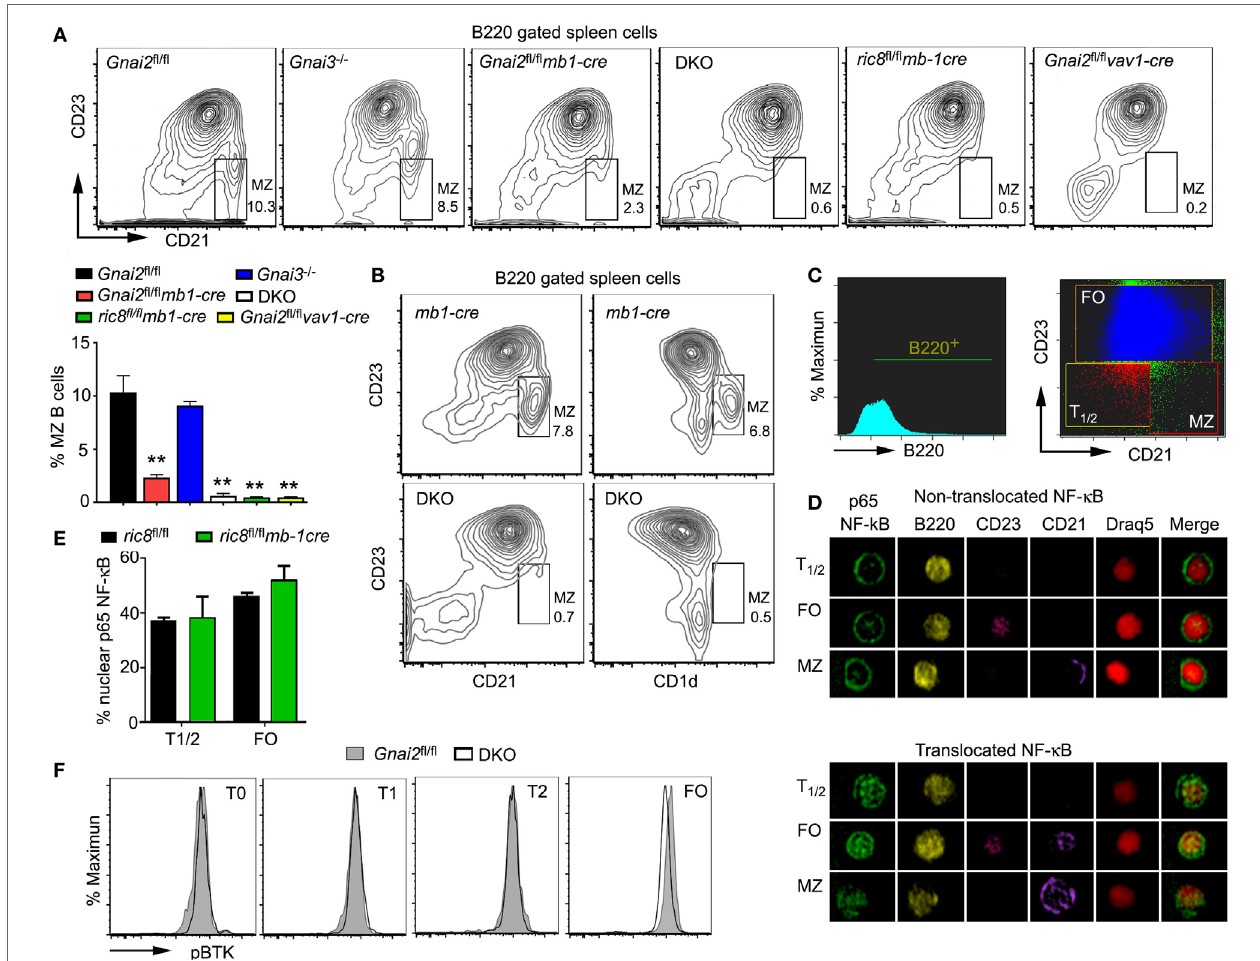
FigUre 1 | Despite the reduction in splenic marginal zone (MZ) B cells in G α i -deficient mice, their transitional B cells do not exhibit evidence of reduced BCR signaling. (a) Lack of MZ B cells in various models of G α i deficiency. Flow cytometry patterns using splenic B cells from G α i -deficient mice. CD23 versus CD21 on WT (Gnai2 fl/fl ), Gnai3 − / − , Gnai2 fl/fl mb1-cre , double knockout (DKO), ric8 fl/fl mb1-cre , and Gnai2 fl/fl vav1-cre B220 + splenocytes. The normal location of MZ B cell is boxed and % of cells indicated. The chart shows percentage of MZ B cells from the B220 + cell gate. Results are from nine WT, five Gnai3 − / − , five r ic8 fl/fl mb1-cre , eight Gnai2 fl/fl mb1-cre , four Gnai2 fl/fl vav1-cre , and four DKO mice. Data shown as mean ± SEM (** p < 0.005). (B) Spleens from G α i -deficient mice also lack CD1d-positive cells. Flow cytometry patterns using splenic B cells from WT and DKO mice. CD23 versus CD21 and CD23 versus CD1d on B220 + splenocytes from mb1-cre and DKO mice. Results representative of one of four pairs of mice analyzed. (c–e) Nuclear factor- κ B (NF- κ B) in WT ( ric8 fl/fl ) and ric8 fl/fl mb1-cre splenic transitional and follicular B cells. Fixed purified B-cells from mb1-cre and ric8 fl/fl mb1-cre mice were immunostained with a p65 antibody and analyzed using Image Stream. Shown